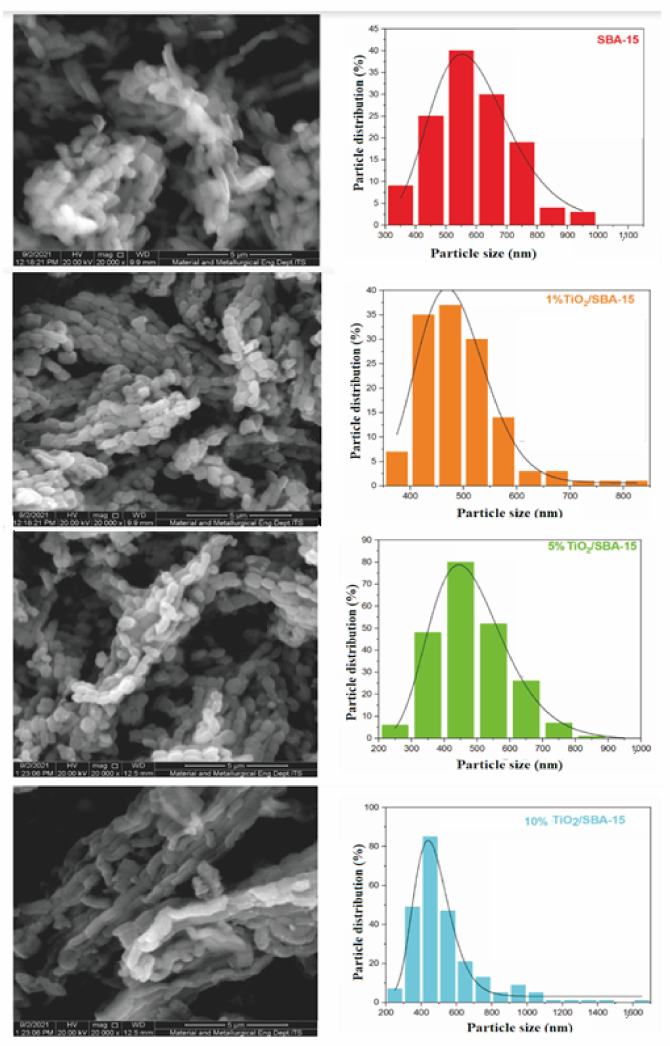
Figure 2. SEM images and particle size distributions of SBA-15 before and after titania